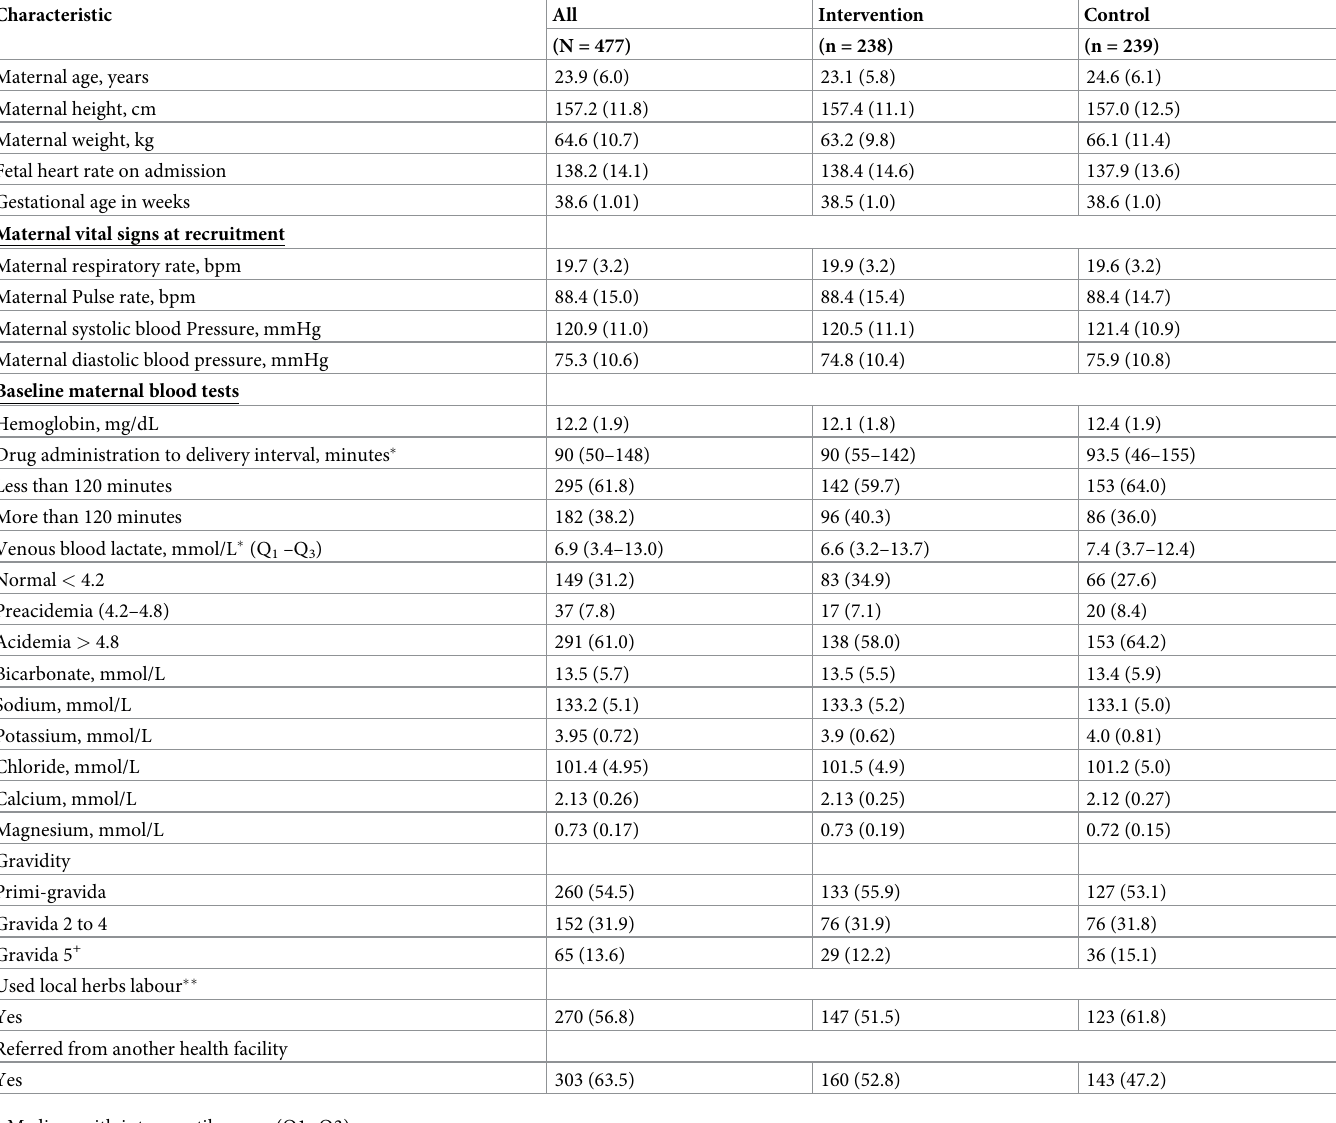
Table 1. Baseline characteristics of study participants, data presented as means (SD) or frequencies (%), except where specified.